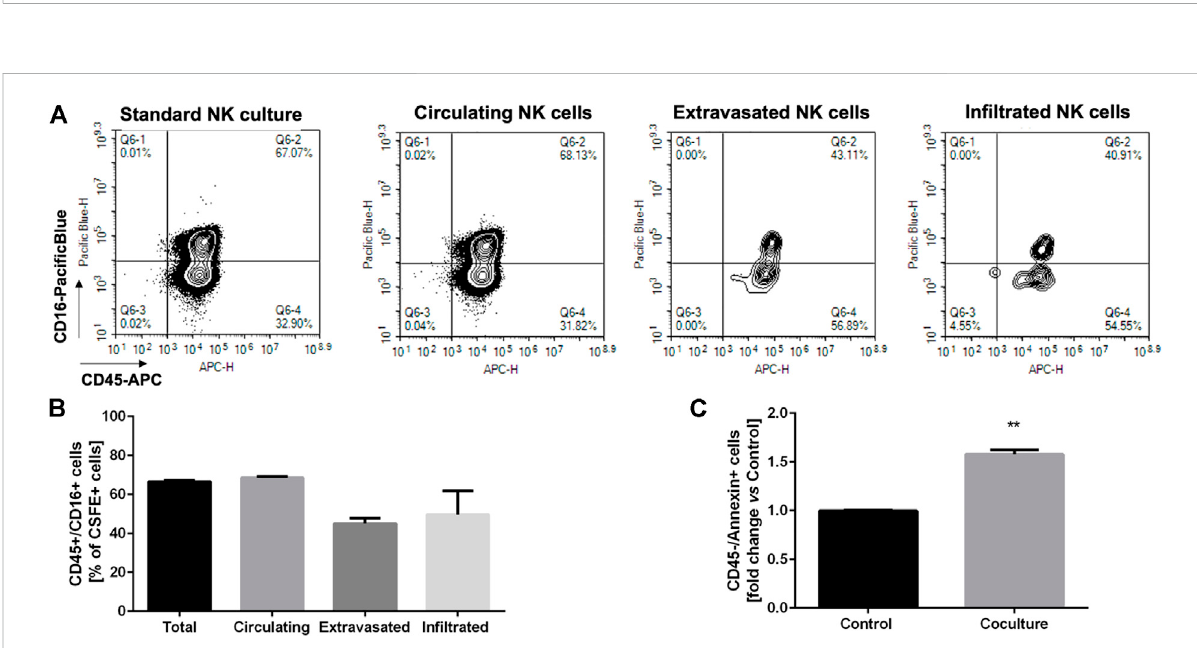
FIGURE 8 Phenotypic characterization of the different fractions of NK cells (A) Representative plotes showing the phenotypic characterization of the different fractions of NK cells recovered from the dynamic culture (in fi ltrated, extravasated, circulating vs . the standard NK culture) based on CD45/ CD16 expression, gated on the CFSE-positive population ( n = 6). (B) Statistical analysis of CD16 expression in the different fractions of NK cells, recoveredfromthedynamicculture( n =6). (C) Inductionofapoptosisintumorcells,assessedthrough fl owcytometryasannexin-Vstainingon CD45-negative cells ( n = 6). Control: HTLA-230 3D